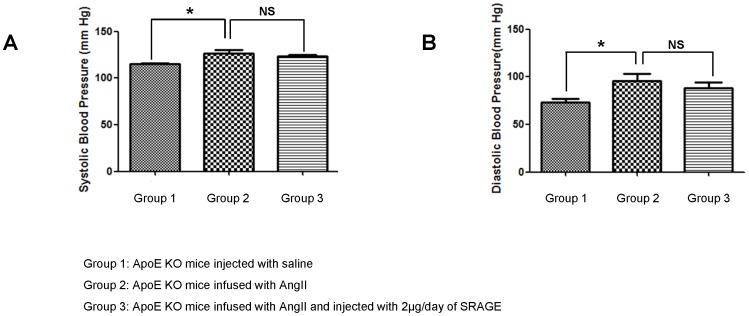
Measurement of Mice Blood Pressure.A. The results from the mice tail systolic and B, diastolic blood pressure. Compared to group 1 and group 2 were associated with significant increase in the blood pressure but, between group 2 and group 3 was not significant. N = 7 for each groups. *p<0.05, ns = non-significant.